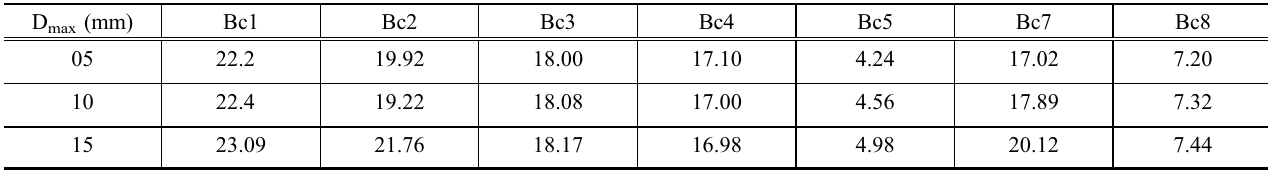
Table 6 Influence of coarse granulate dimension to the binary concretes on the compressive strength (in MPa) after 40 freeze thaw